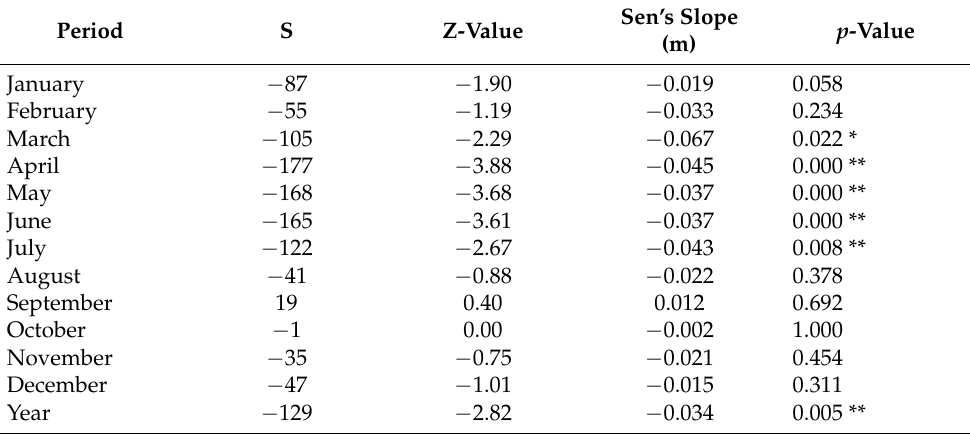
Table 3. Changes in mean monthly and annual water levels in the Jeziorsko reservoir in the period 1995–2021.